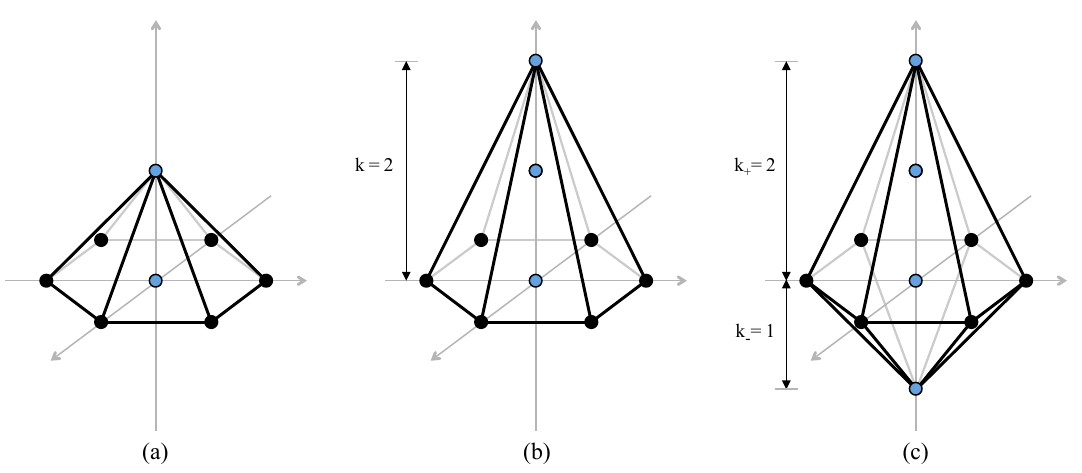
Figure 7. Toric diagrams for: a) the dimensional reduction of dP 3 to dP 3 orbifold with k = 2 and c) an orbifold reduction of dP 3 with k + = 2 and k (cid:0) = 1. Orbifolding. Using k copies of the same quiver block (cid:15) periodic quiver for an orbifold of the form CY Orbifold reduction. This process uses k (cid:15) orientation and k